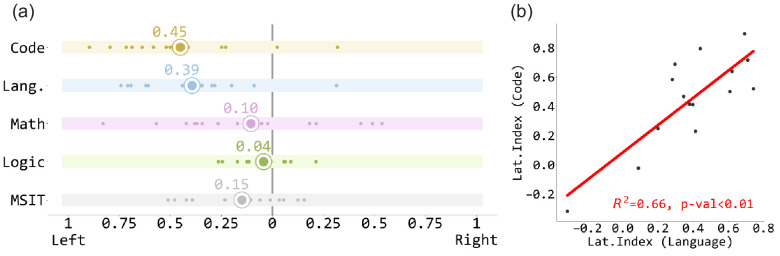
The lateralization index of the code contrast and the localizer contrasts.(a) The lateralization index of the code contrast and the localizer contrasts. Each white dot stands for one participant, and the enlarged dots represent the mean values. (b) The lateralization indices of code contrast and language contrast are highly correlated.